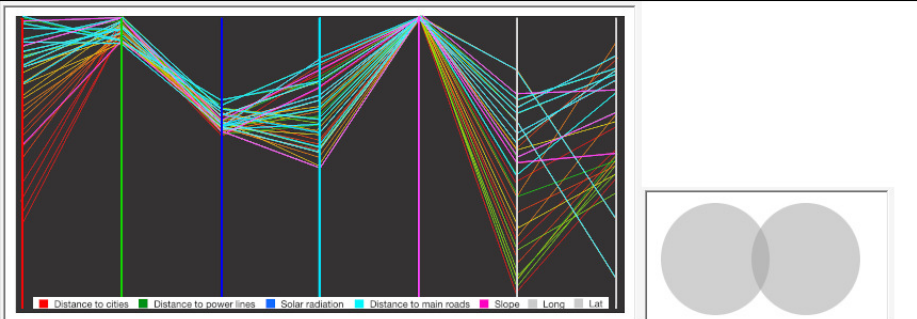
Figure 10. The parallel coordinates plot and the complementary diagram after applying comparison with AHP.